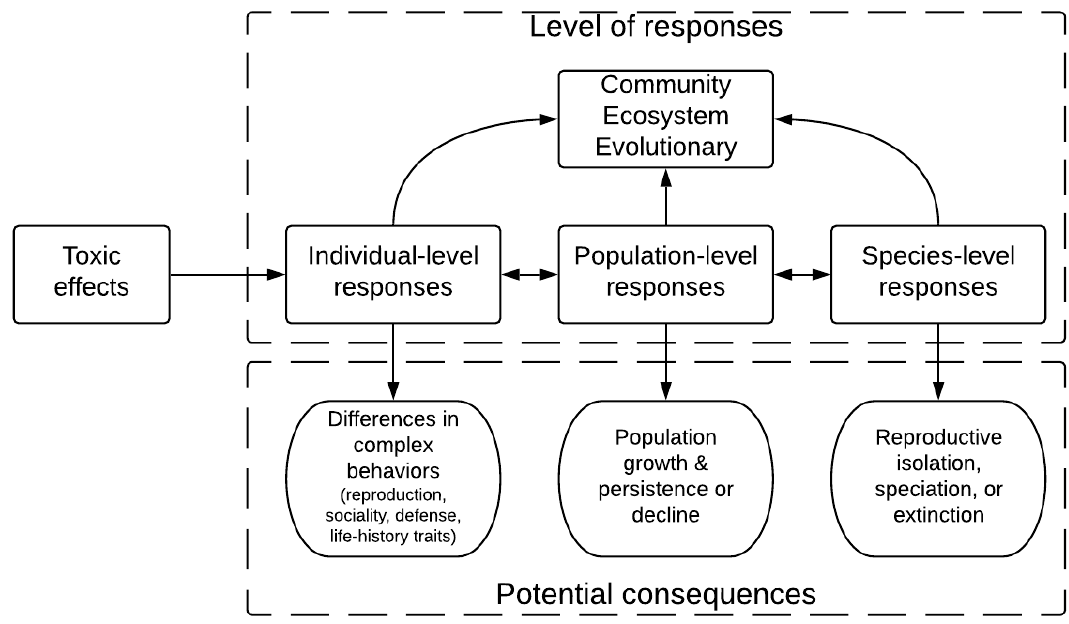
Figure 1. Toxic e ff ects can act at di ff erent response levels (individual, population, species, community, Figure 1. Toxic effects can act at different response levels (individual, population, species, community, ecosystem, or evolutionary levels) to produce di ff erent consequences on fitness. Behavioral e ff ects ecosystem, or evolutionary levels) to produce different consequences on fitness. Behavioral effects impact not only the individual level, but its interaction with other levels as impact not only the individual level, but its interaction with other levels as well.